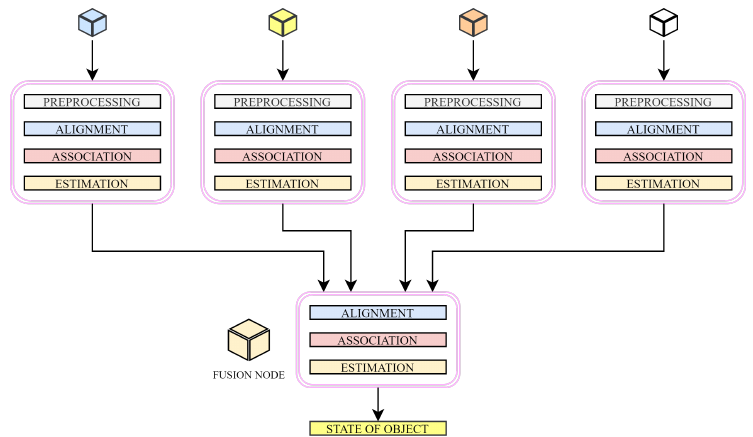
Figure 3. Example of distributed